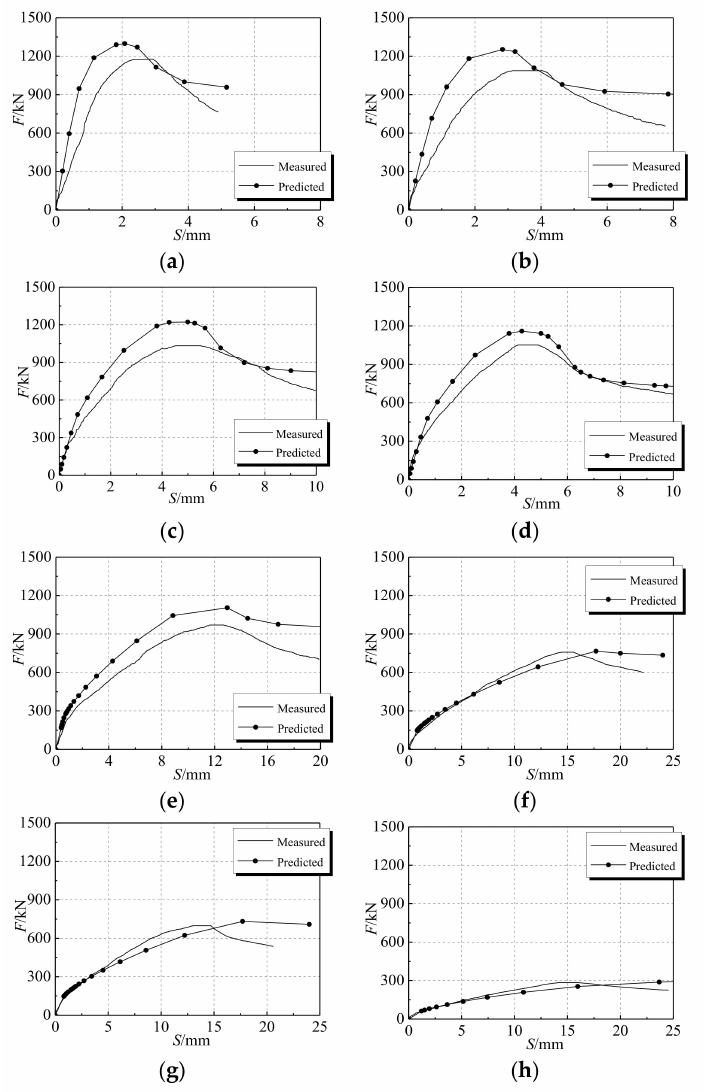
Figure 9. Load–displacement of experiment and numerical simulation ( a ) DS-20; ( b ) DS-100; ( c ) DS-200; ( d ) DS-200-0; ( e ) DS-400; ( f ) DS-600; ( g ) DS-600-0; ( h )